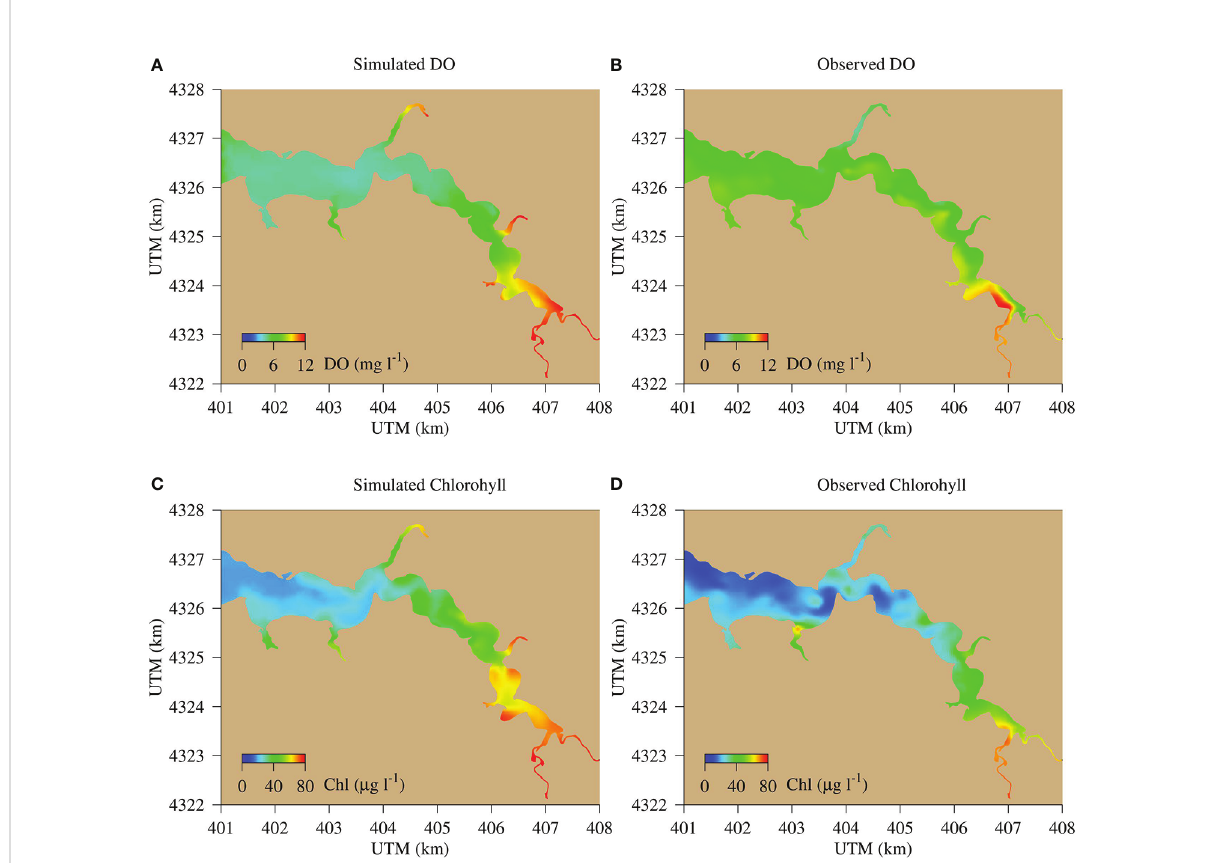
FIGURE 5 Comparison between model simulations (left panels) with sensor-based synoptic survey data (right panels) for DO (A, B) and chlorophyll (C, D) on July 20, 2006. The survey data were provided by the Department of Natural Resources (DNR) of Maryland and available at https://